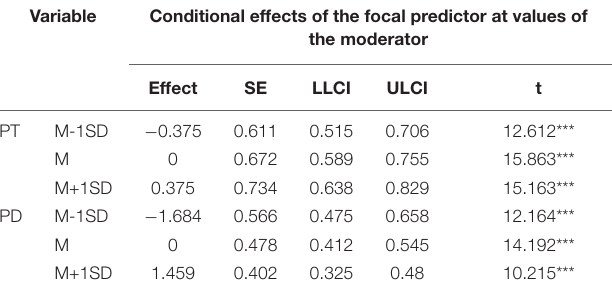
TABLE 6 | Moderating effects of PT and PD on different levels.